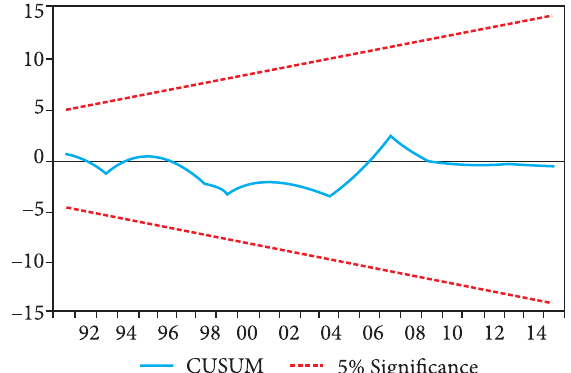
Figure 1. Plot of CUSUM of recursive residuals (Asymmetric